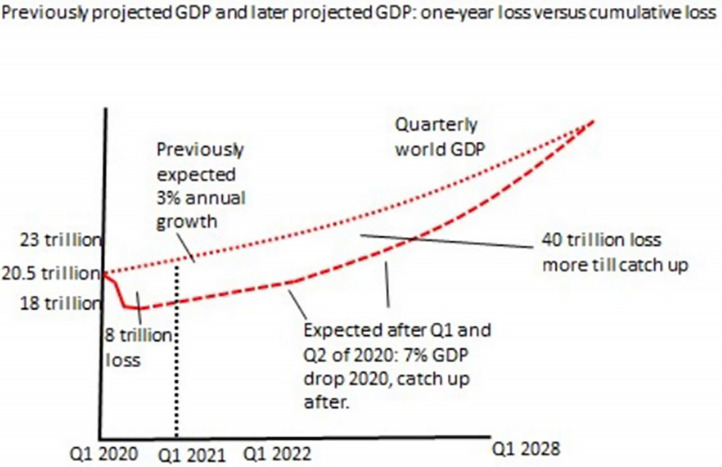
Explanation of how acute GDP loss of 6-7% will accumulate over the decade to a loss of at least US$50 trillion. Reproduced with permission from Frijters (Personal Communication).